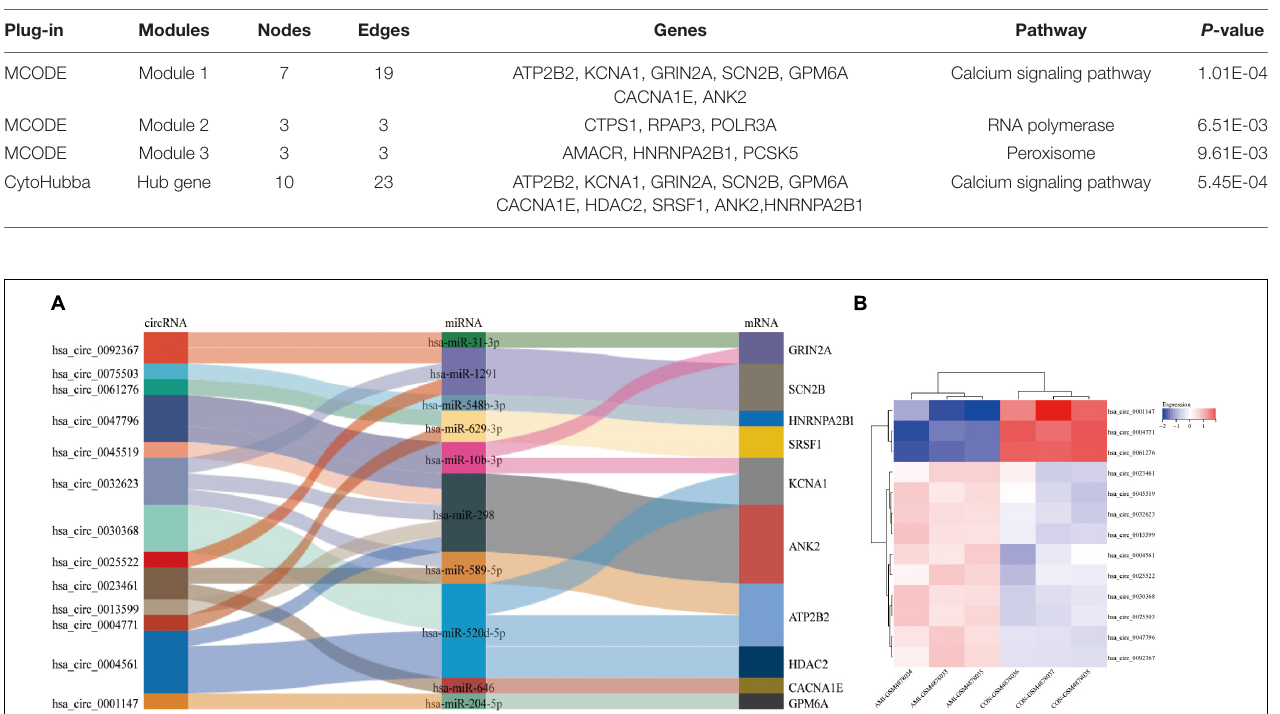
Frontiers in Cardiovascular Medicine |